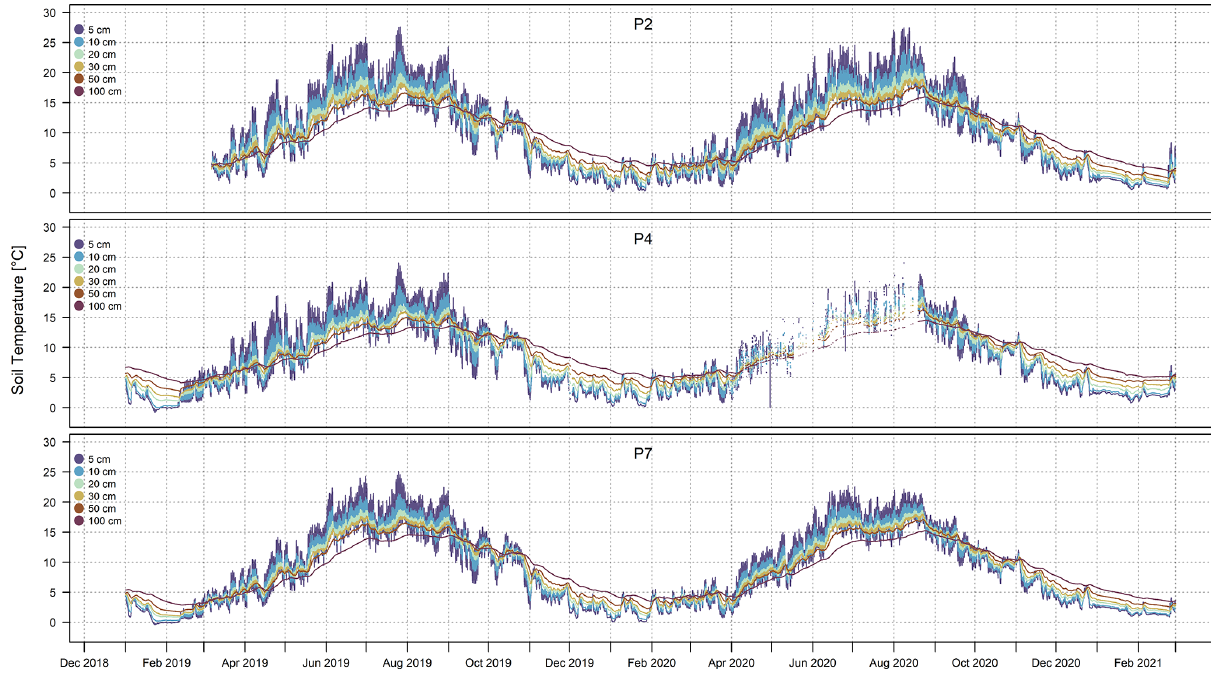
Figure 5. Time series of soil temperature data. The plots were made using the data set as it appears in the online archive. The data are plotted using a scientific colour scale from Crameri (2018) chosen according to the principles described in Crameri et al. (2020).